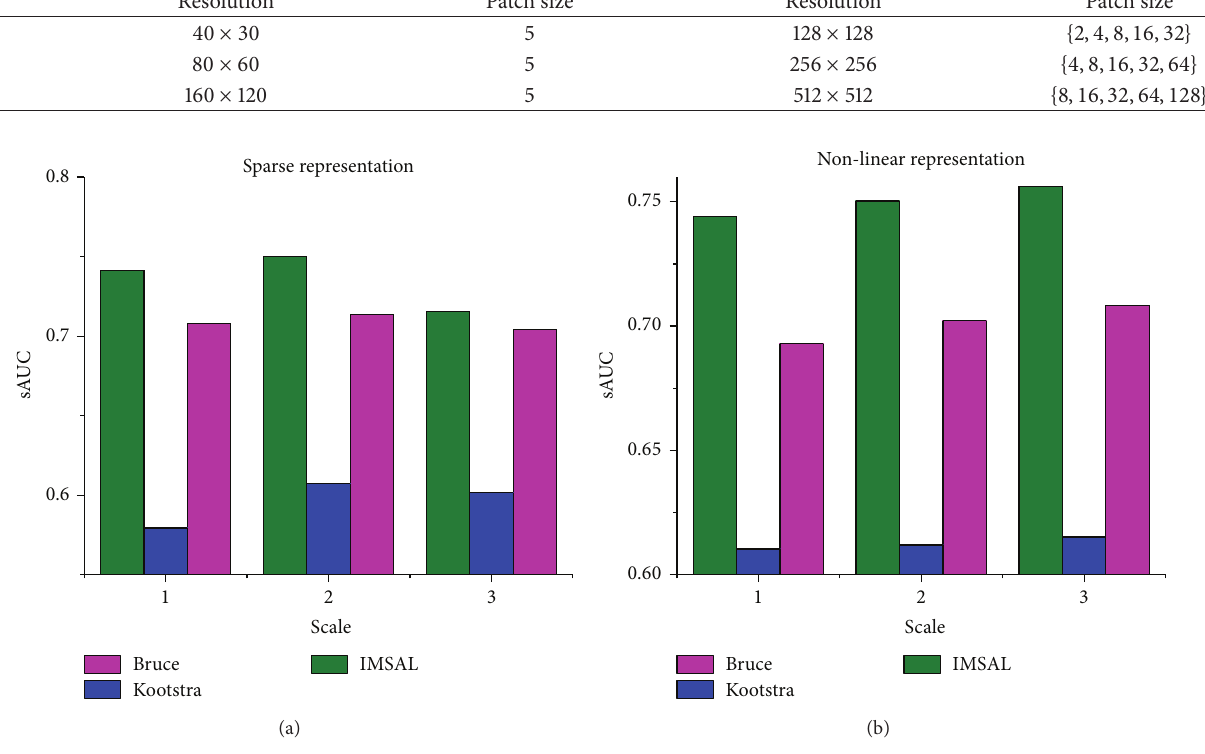
Figure 5: sAUC score for sparse and nonlinear representation. The values in (a) and (b) are maximum at scale 2 and scale 3 for all three